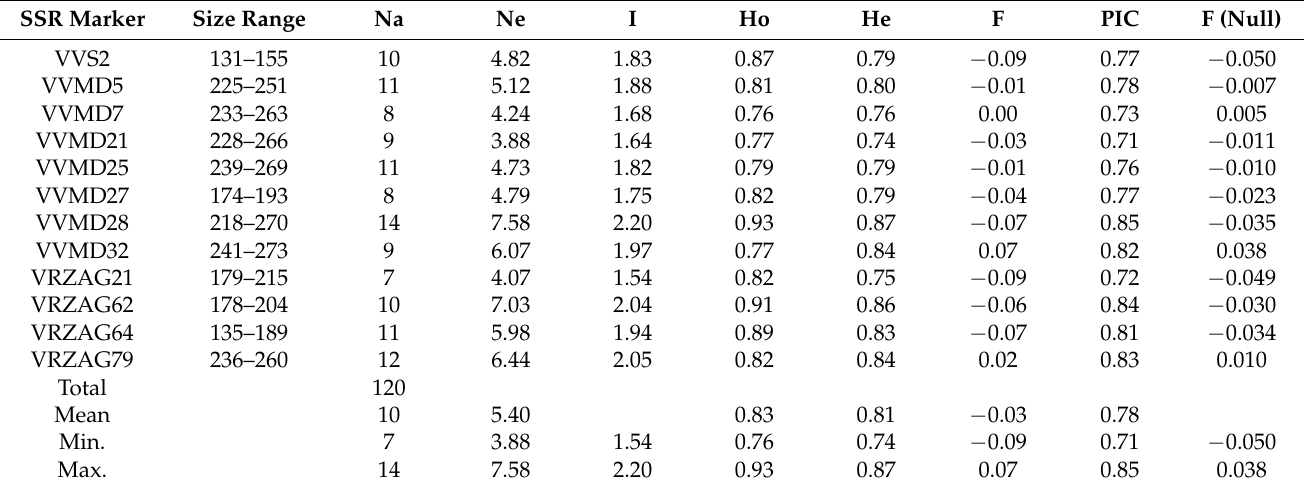
Table 2. Diversity indices of 12 SSR markers detected in a set of 97 grapevine